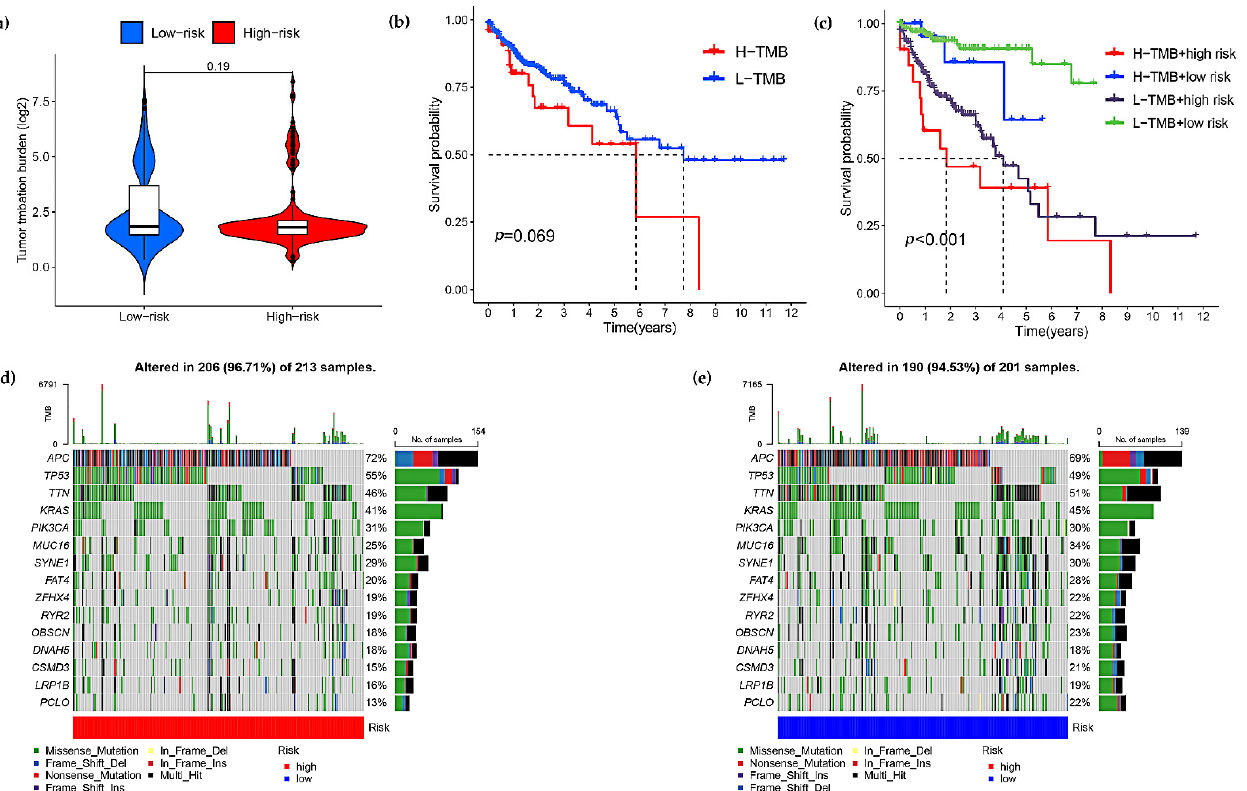
Figure 6. Correlations between the risk score model and somatic variants. ( a ) Differential analysis of tumor mutational burden (TMB) between high and low risk subgroups for colon adenocarcinoma. ( b ) Correlation between the prognosis and TMB in COAD patients. ( c ) Predictive power of risk model in high and low TMB groups. ( d , e ) Compare the mutation rates of reported prognosis-associated genes in low- and high-risk groups.